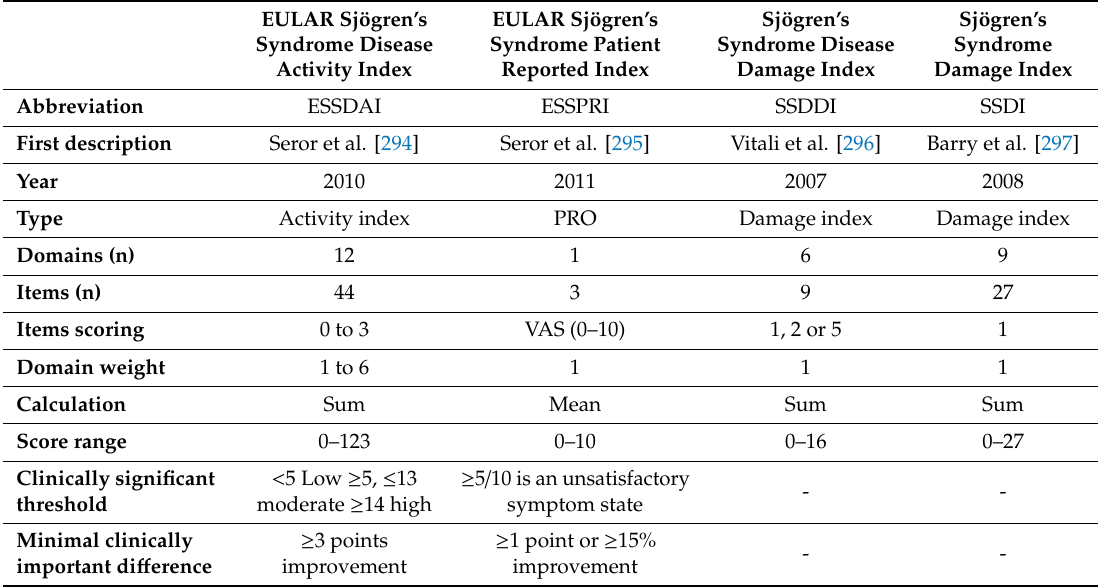
Table 4. Common damage, burden and activity scores for clinical monitoring of pSS